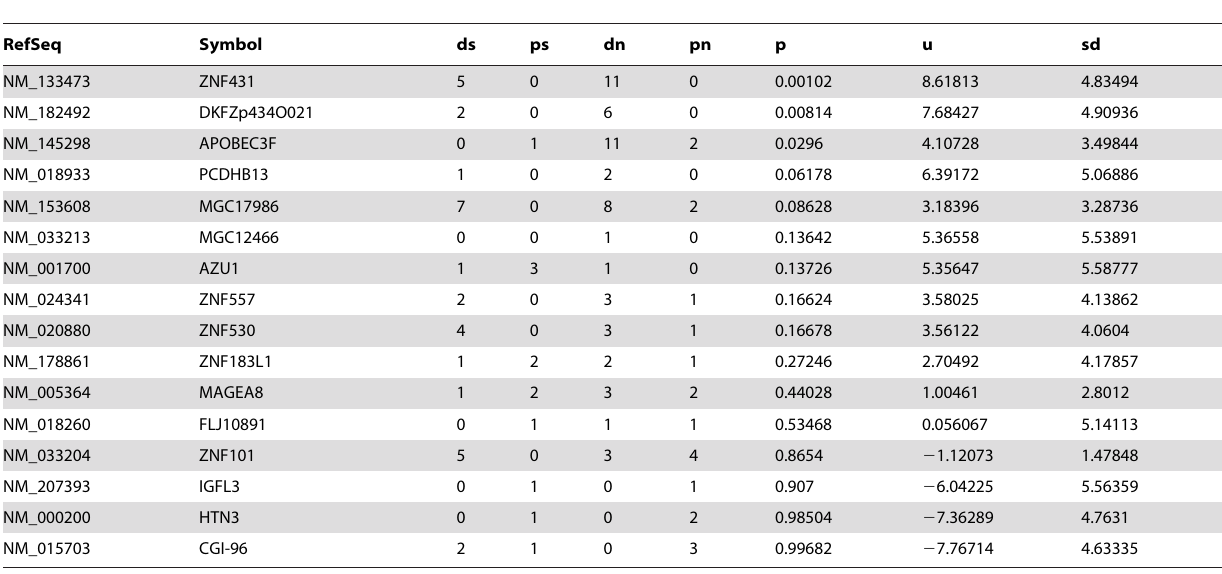
Table 2. Selection intensity on 16 young fetal brain biased genes estimated by McDonald–Kreitman tests with Poisson random field